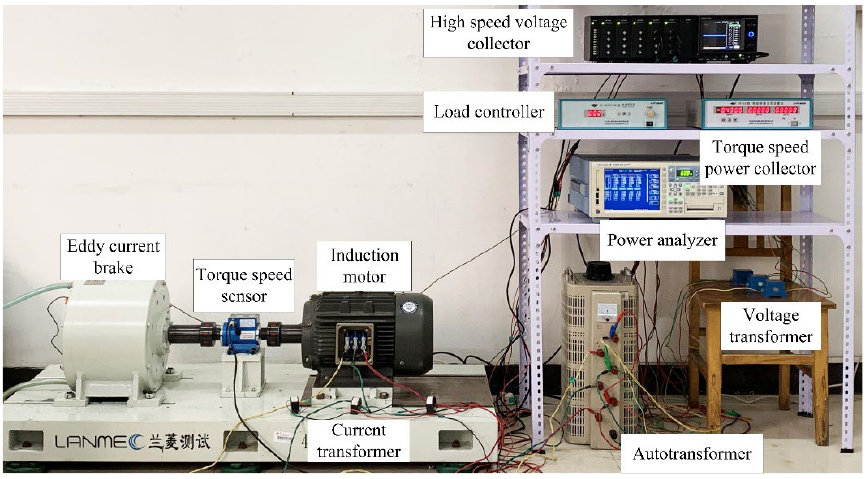
Figure 15. Efficiency test experimental platform.